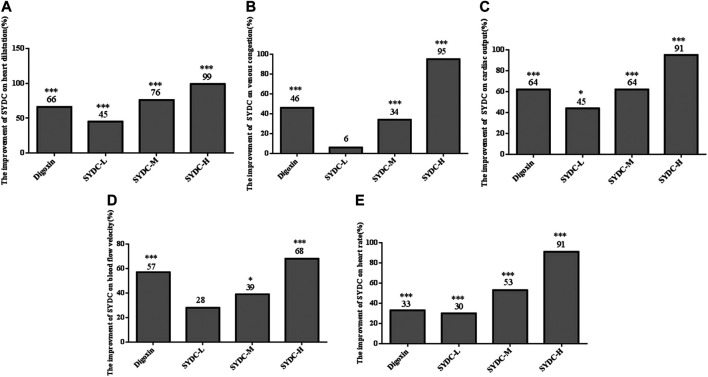
The efficiency improvement of enlarged heart area, venous congestion, cardiac output, blood flow velocity, and heart rates in HF zebrafish treated with SYDC for 4 h. *Compared with the model control, p < 0.05; ***compared with the model control, p < 0.001.